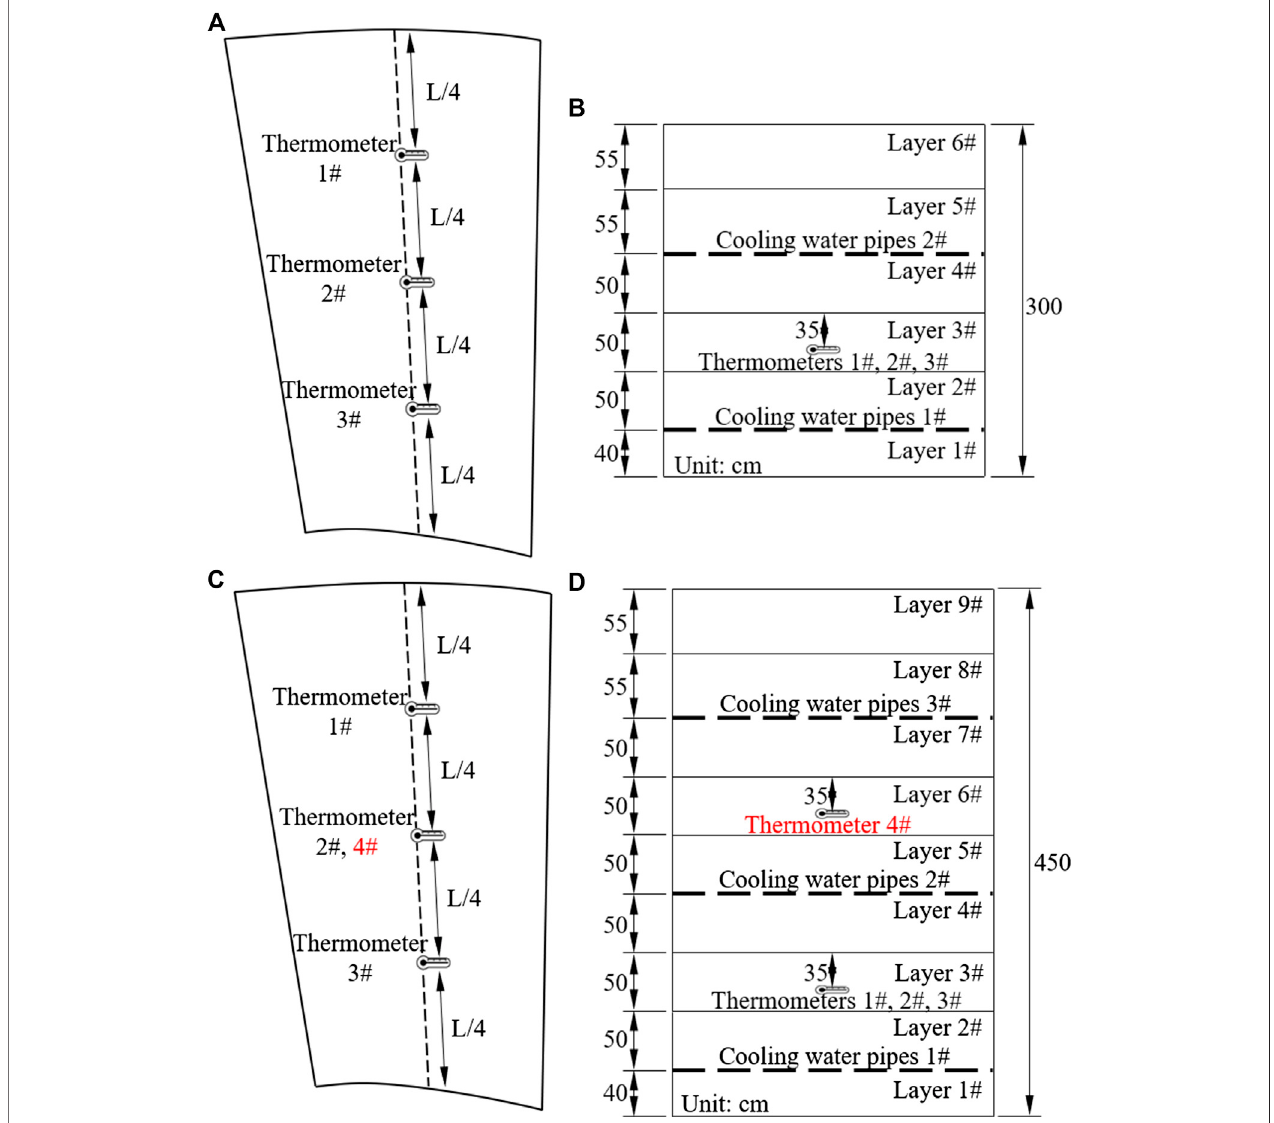
FIGURE 7 | Position of thermometers in concrete blocks below EL910m: (A) in horizontal direction (3 m); (B) in vertical direction (3 m); (C) in horizontal direction (4.5 m); (D) in vertical direction (4.5 m).